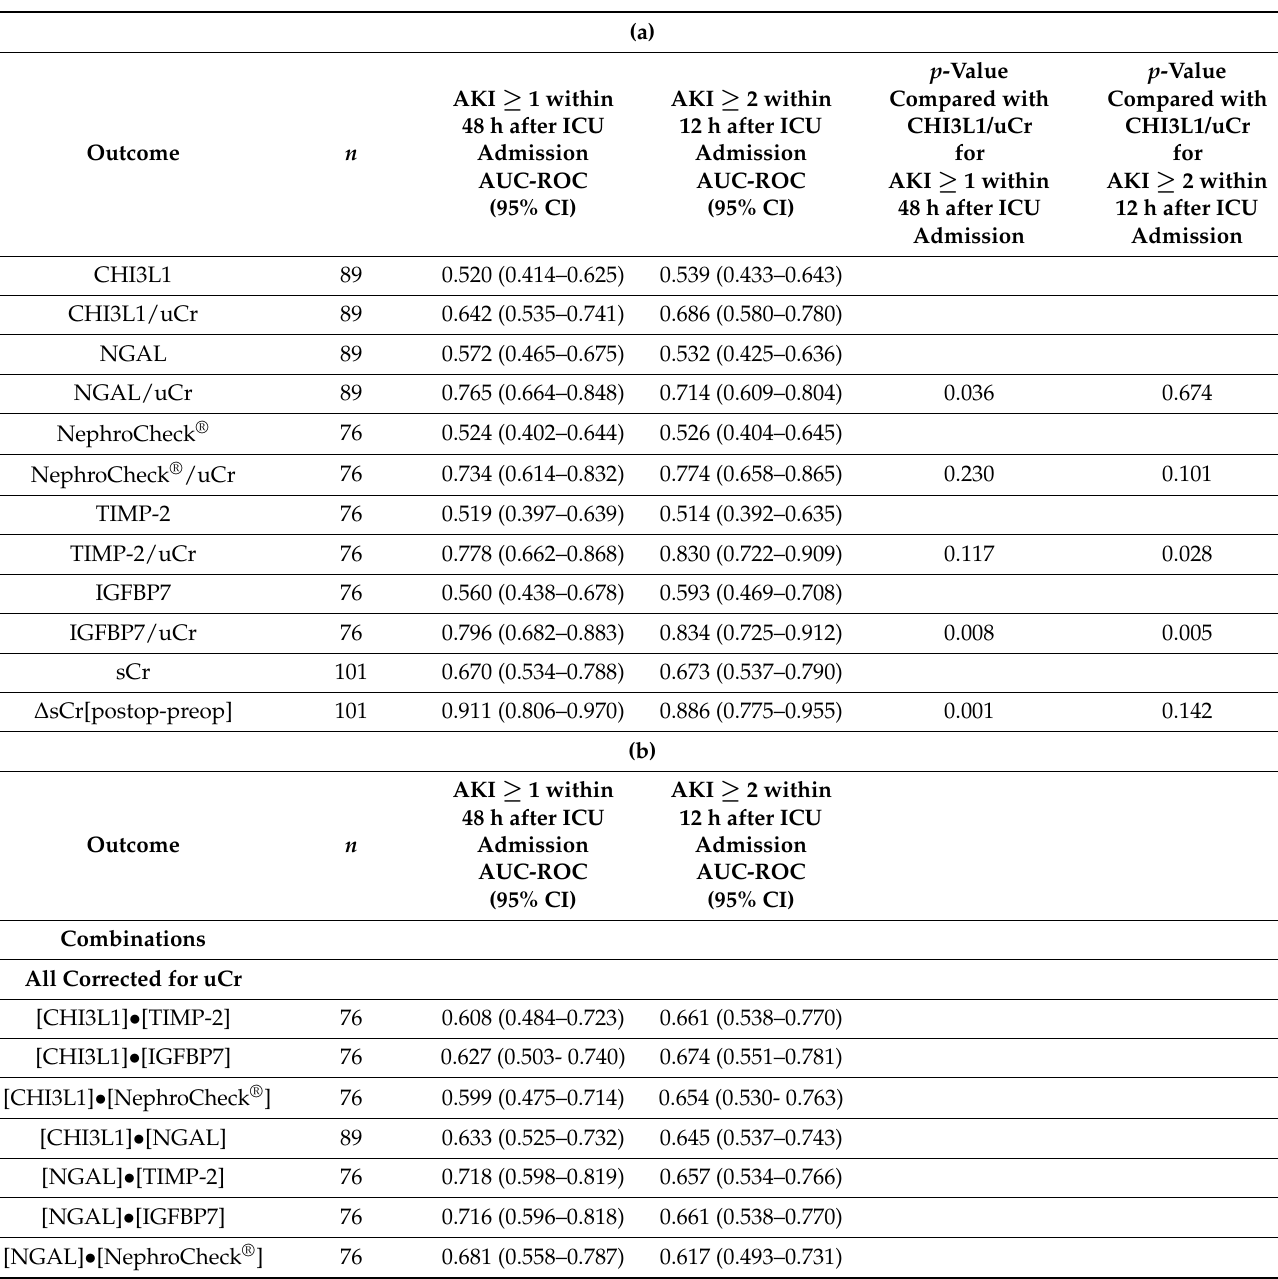
Table 4. (a) Predictive value of acute kidney injury by biomarkers measured 4 h after ICU admission in urine. (b) Predictive value of acute kidney injury by biomarker combinations measured 4 h after ICU admission in urine.